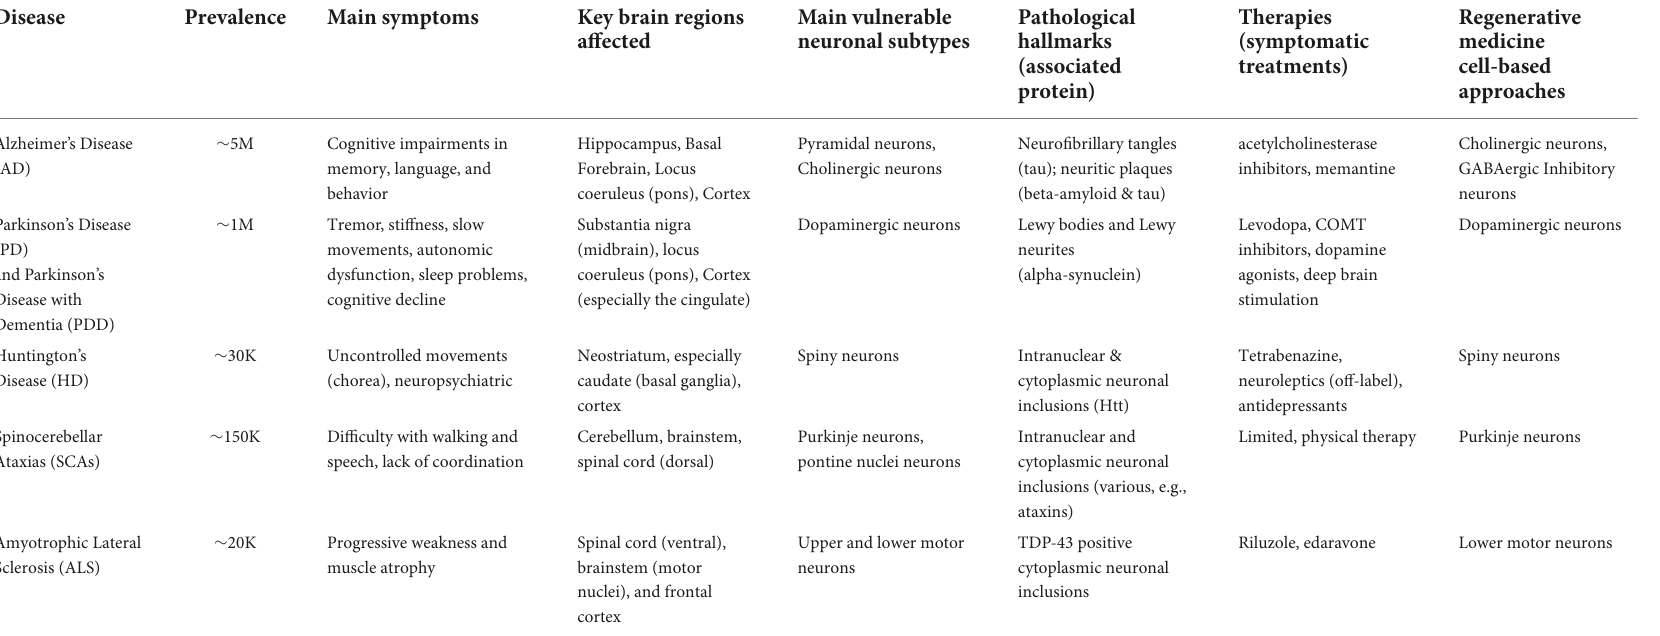
TABLE 1 Common neurodegenerative diseases characterized by selective